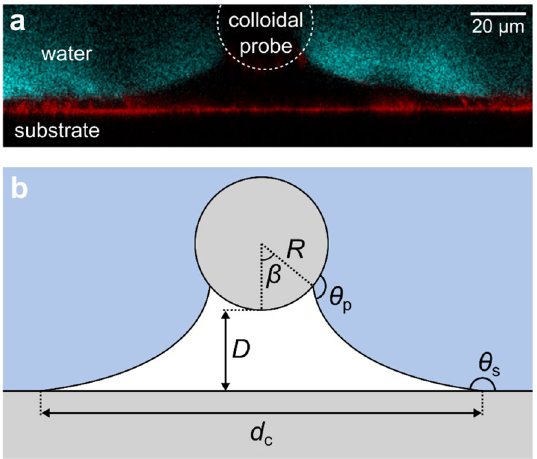
Figure 2. ( a ) Laser scanning confocal image of a gas capillary between the particle and superamphiphobic surface captured during retraction in water and ( b ) illustration of a catenary shape gas capillary between a spherical particle (radius R ) and a flat surface at separation D , with the diameter of the de-wetted area on the flat surface ( d c ), the angle defining the de-wetted area on the particle ( β ) and the microscopic contact angles at the gas–liquid interface of the flat surface ( θ s ) and particle ( θ p